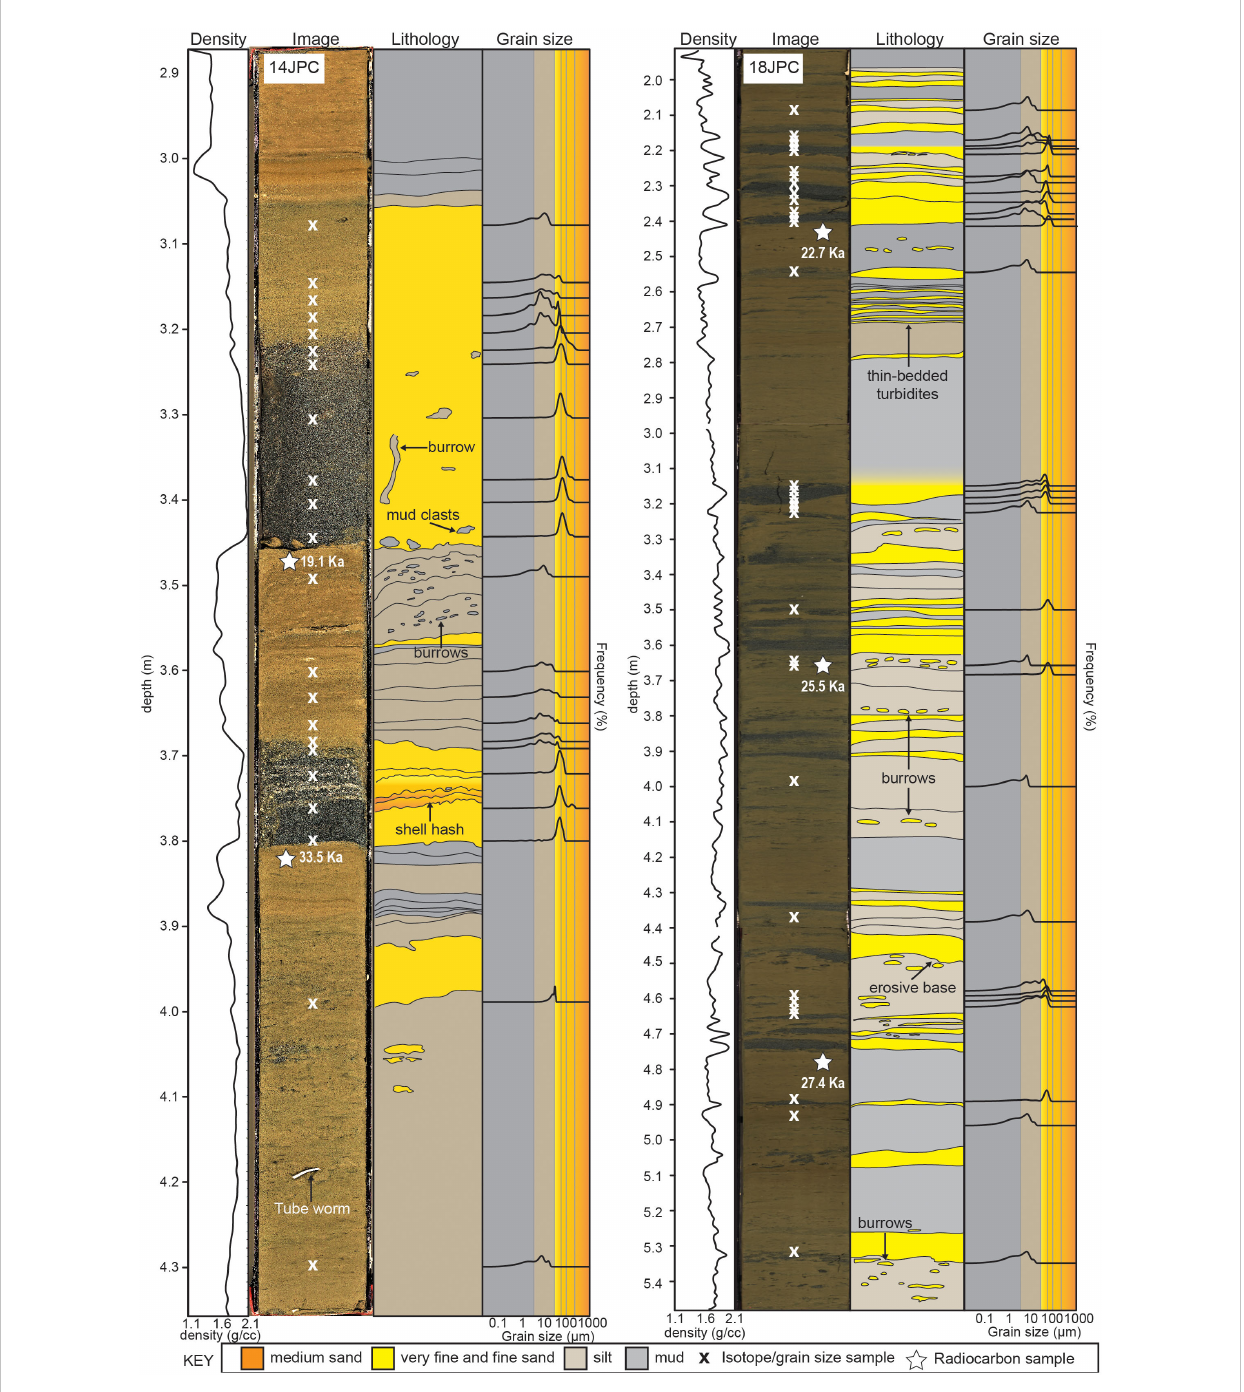
FIGURE 4 Density logs, photographs, descriptions, and grain size frequency plots of jumbo-piston cores 14JPC and 18JPC. Xs mark the sample location for both grain size and isotopic analyses. Stars mark radiocarbon sample locations. Note these are selected portions of the cores, not the entire cores. The apparent variation in core color between 14JPC and 18JPC is a function of camera settings when photographs were collected and not indicative of difference between